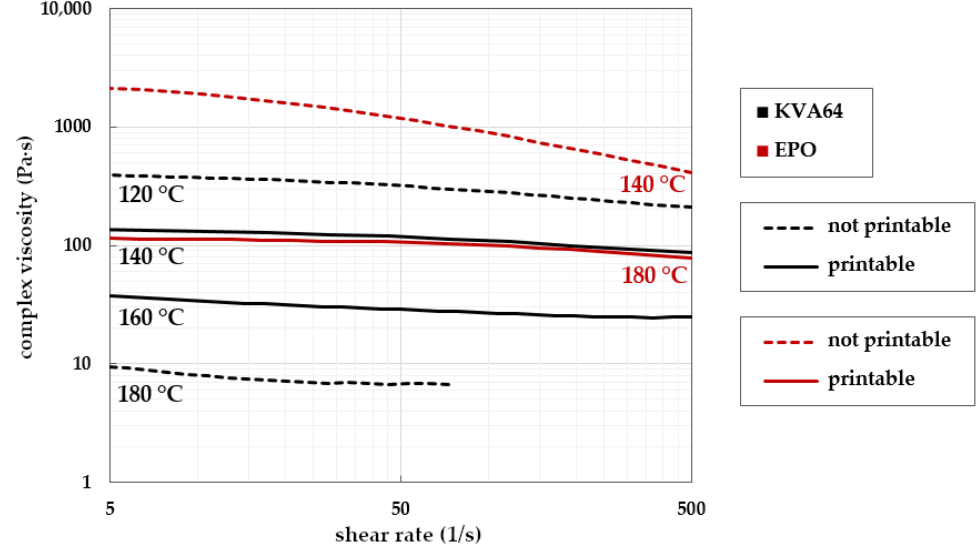
Figure 5. Complex viscosities of placebo formulations KVA64/PEG (black lines) and EPO (red lines) in relation to shear rate monitored at different temperatures; temperatures for successful print runs are symbolized by continuous lines, unsuitable temperature runs in dotted lines.